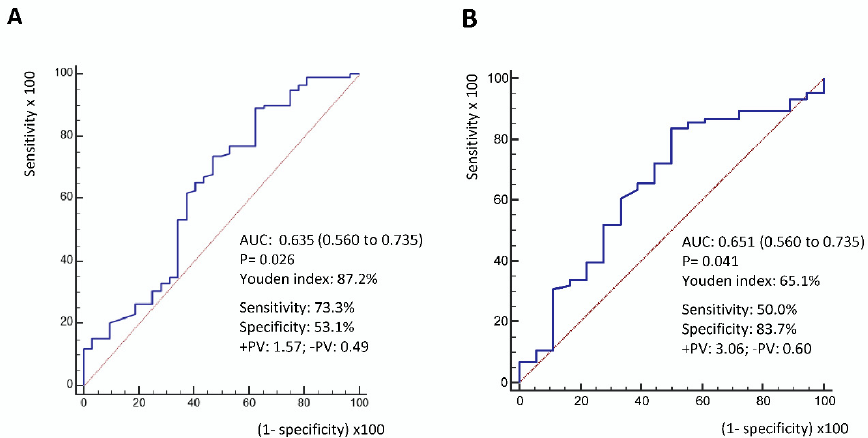
Figure 2. ( A ) The ROC curve of day 1-HLA-DR for 28-day mortality prediction. The best cut- for day 1-HLA-DR determined using the ROC curve and Youden index was 87.2%. ( B ) The ROC curve off point for day 1-HLA-DR determined using the ROC curve and Youden index was 87.2%. of day 7 caloric meet for 28-day mortality prediction. The best cut-off point for day 7 caloric meets ( B ) The ROC curve of day 7 caloric meet for 28-day mortality prediction. The best cut-off point determined using the ROC curve and Youden index was 65.1%. PV: predictive for day 7 caloric meets determined using the ROC curve and Youden index was 65.1%. * PV: predictive value.